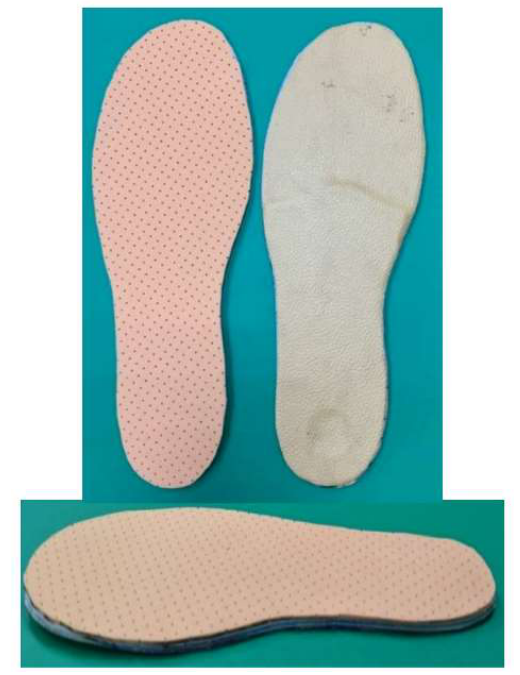
Figure 3. Example of flat insole used in the study.